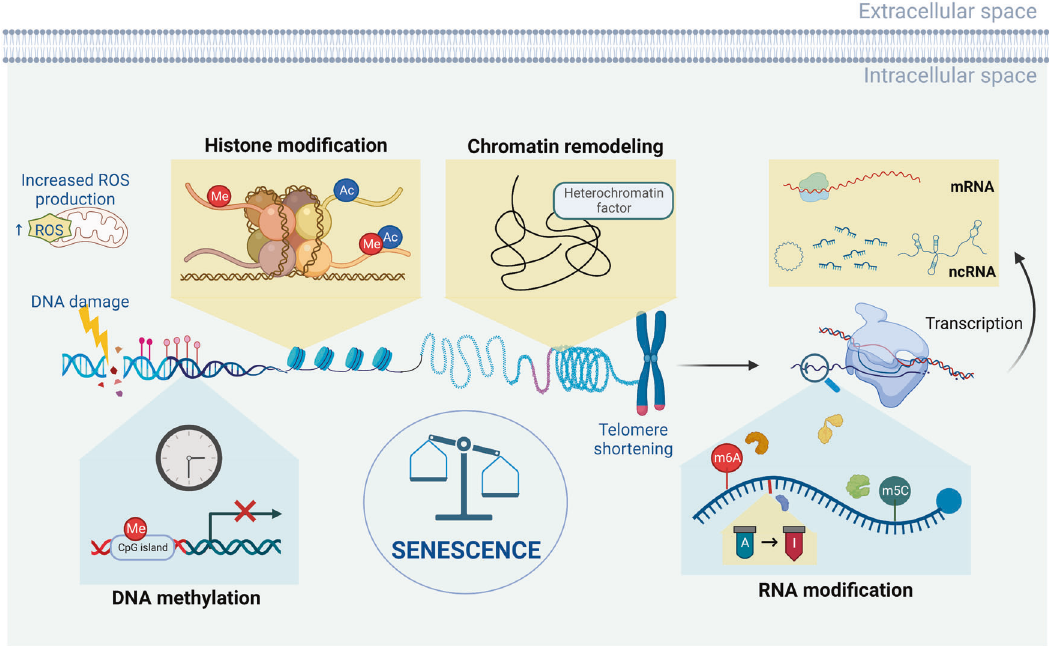
Fig. 2 An overview of the aging epigenome. During aging and the emergence of cellular senescence, a series of epigenetic changes occur in cells, including alterations in DNA methylation, chromatin remodeling, histone modi fi cation, RNA modi fi cation, and ncRNA